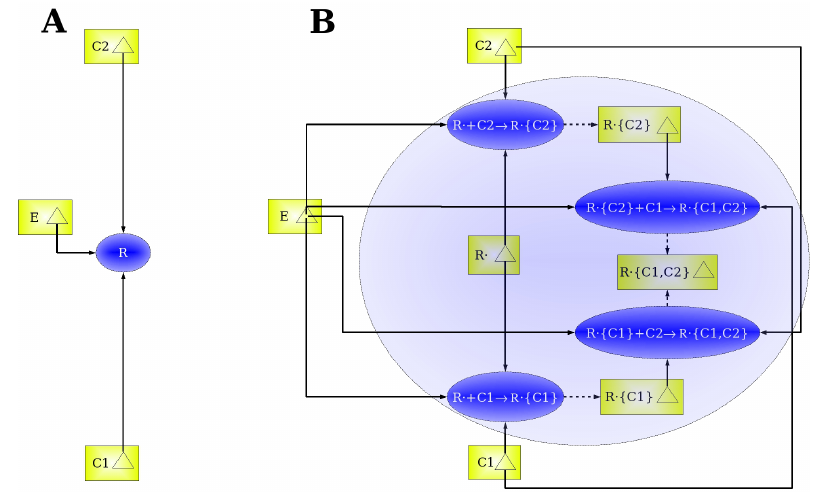
Figure 4: Example of a regulatory site demultiplication with two regulating species and an en- zyme; only ICR are illustrated (except in the gray oval).